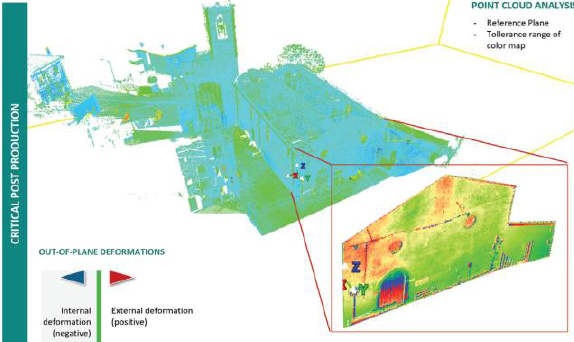
Figure 8 . Reference and extraction of 2D elevation